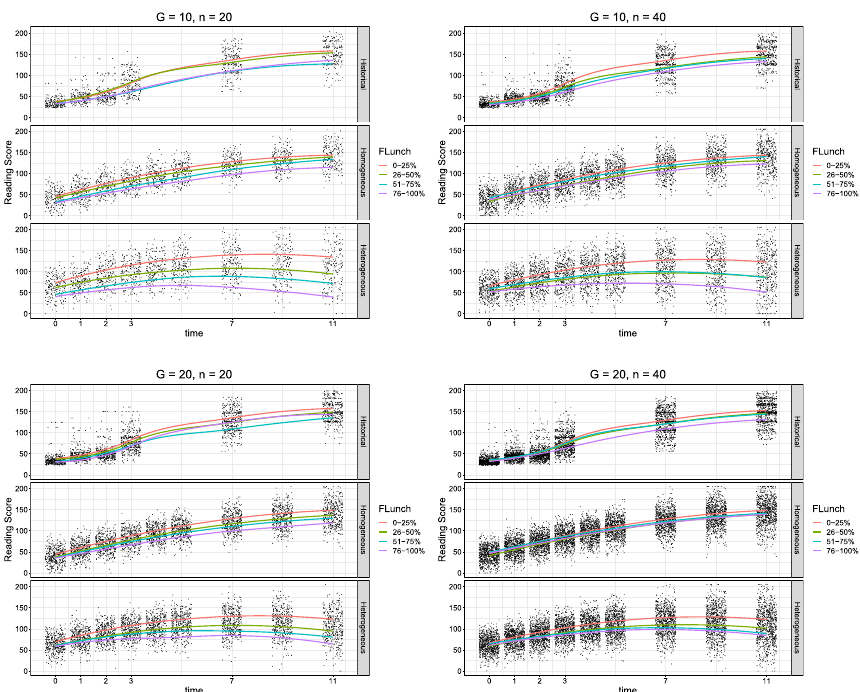
Fig. 1 Growth trajectories of one simulated data set for different sample size and heterogeneity